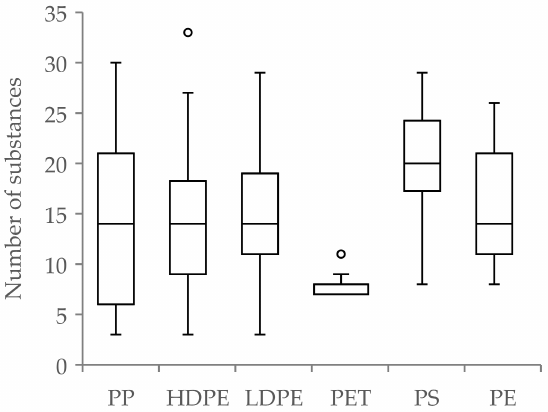
Figure 1. Boxplot analysis for the number of detected substances for each polymer. This was done by counting the number of detected substances in each sample. (° = Outlier). Table 1. Calculated diversity indices (Shannon-index; Simpson-index) and evenness for each polymer. HDPE LDPE PE PET PP Shannon